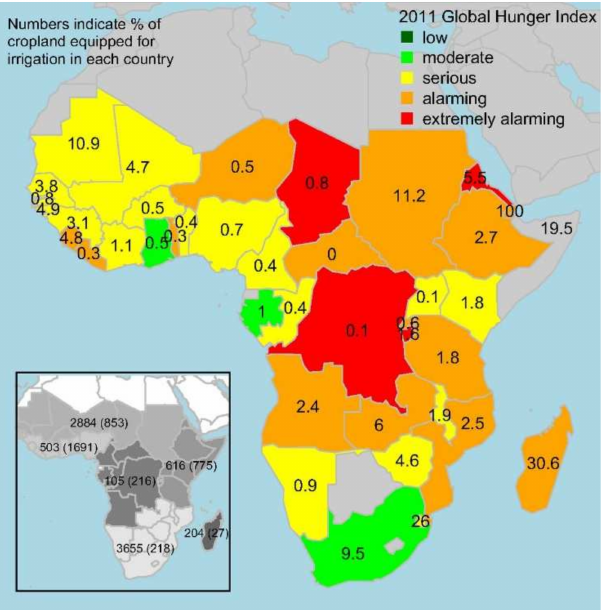
Figure 4. 2011 Global Hunger Index and irrigation coverage